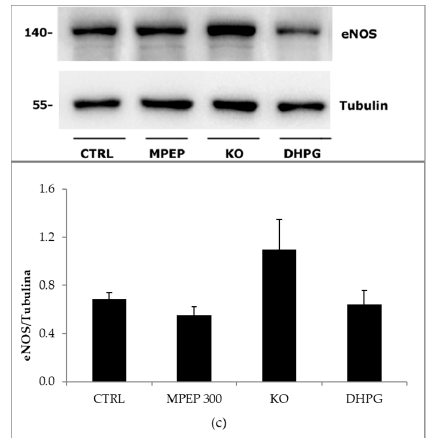
Figure 8. Hepatic expression of TNF- α , iNOS and eNOS in a model of cold storage/reperfusion injury.